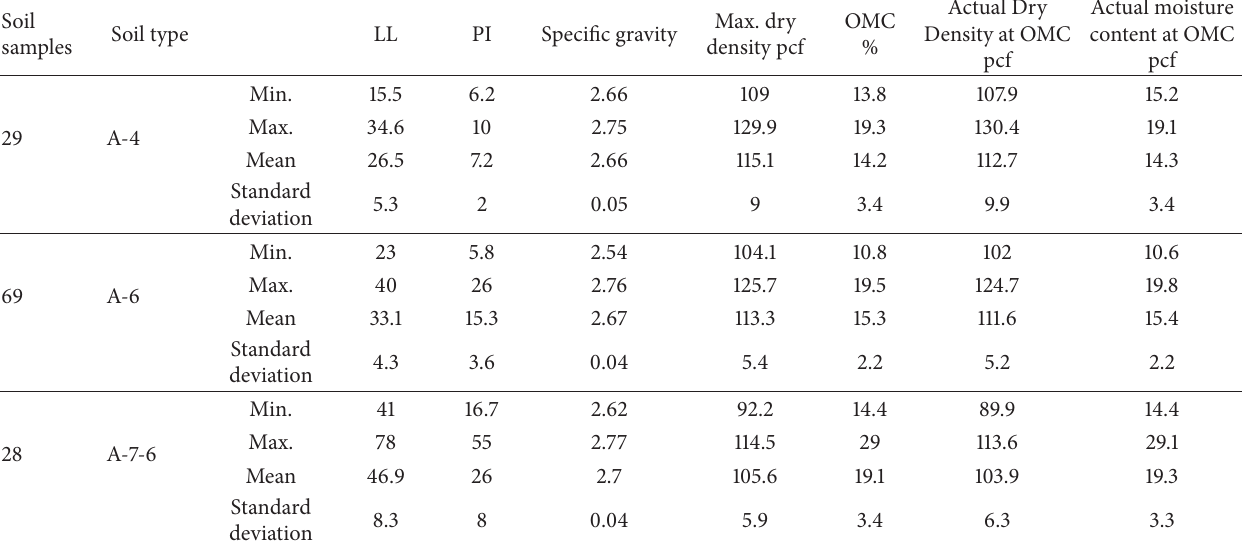
Table 1: Basic statistical parameters for soil